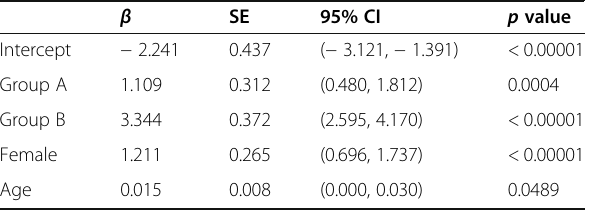
Table 2 The result of regression using the generalized linear mixed